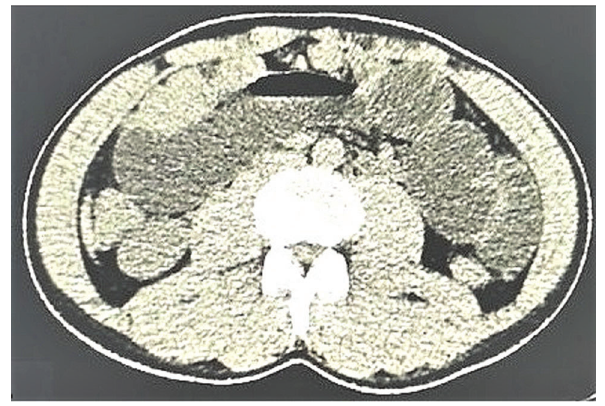
Figure 4 - Computed tomography showing a suspected mass- mimicking lesion in the right kidney in a 55-year-old man with clear cell renal